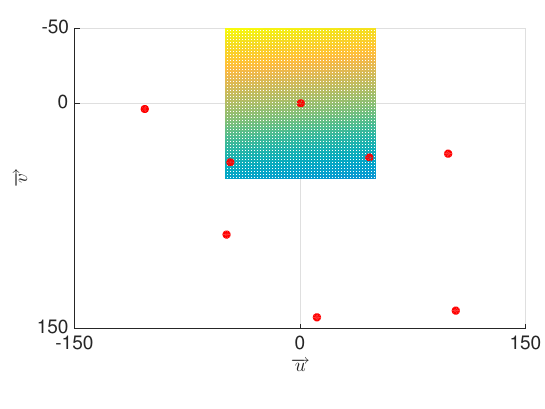
Figure 3: A 100 × 100 grid is created to generate the surface at the local neighborhood. This local neighborhood is shown in Figure (1.a) with a red rectangle. Depth map should be estimated for the points on the grid to reconstruct the surface in this neighborhood.